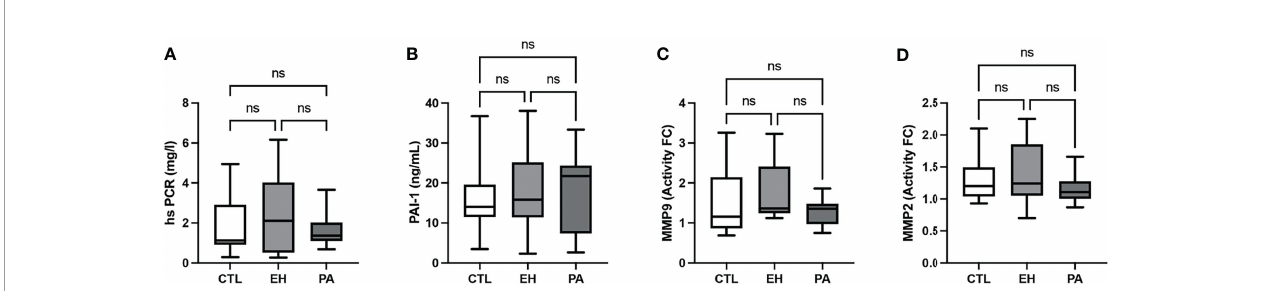
FIGURE 3 | Evaluation of parameters associated with in fl ammation, endothelial and renal dysfunction in PA subjects. (A) High sensitivity C reactive protein (hsPCR; mg/L). (B) Plasminogen activator inhibitor – 1 (PAI-1; ng/mL). (C) Metalloproteinase 9 (fold change activity). (D) Metalloproteinase 2 (fold change activity). No differences of parameters associated with in fl ammation, endothelial and renal dysfunction were found between groups. Comparison between groups was performed by unpaired one-way ANOVA or Kruskal-Wallis test. Data are presented as a median and interquartile range [Q1-Q3], N.S, No signi fi cative difference.